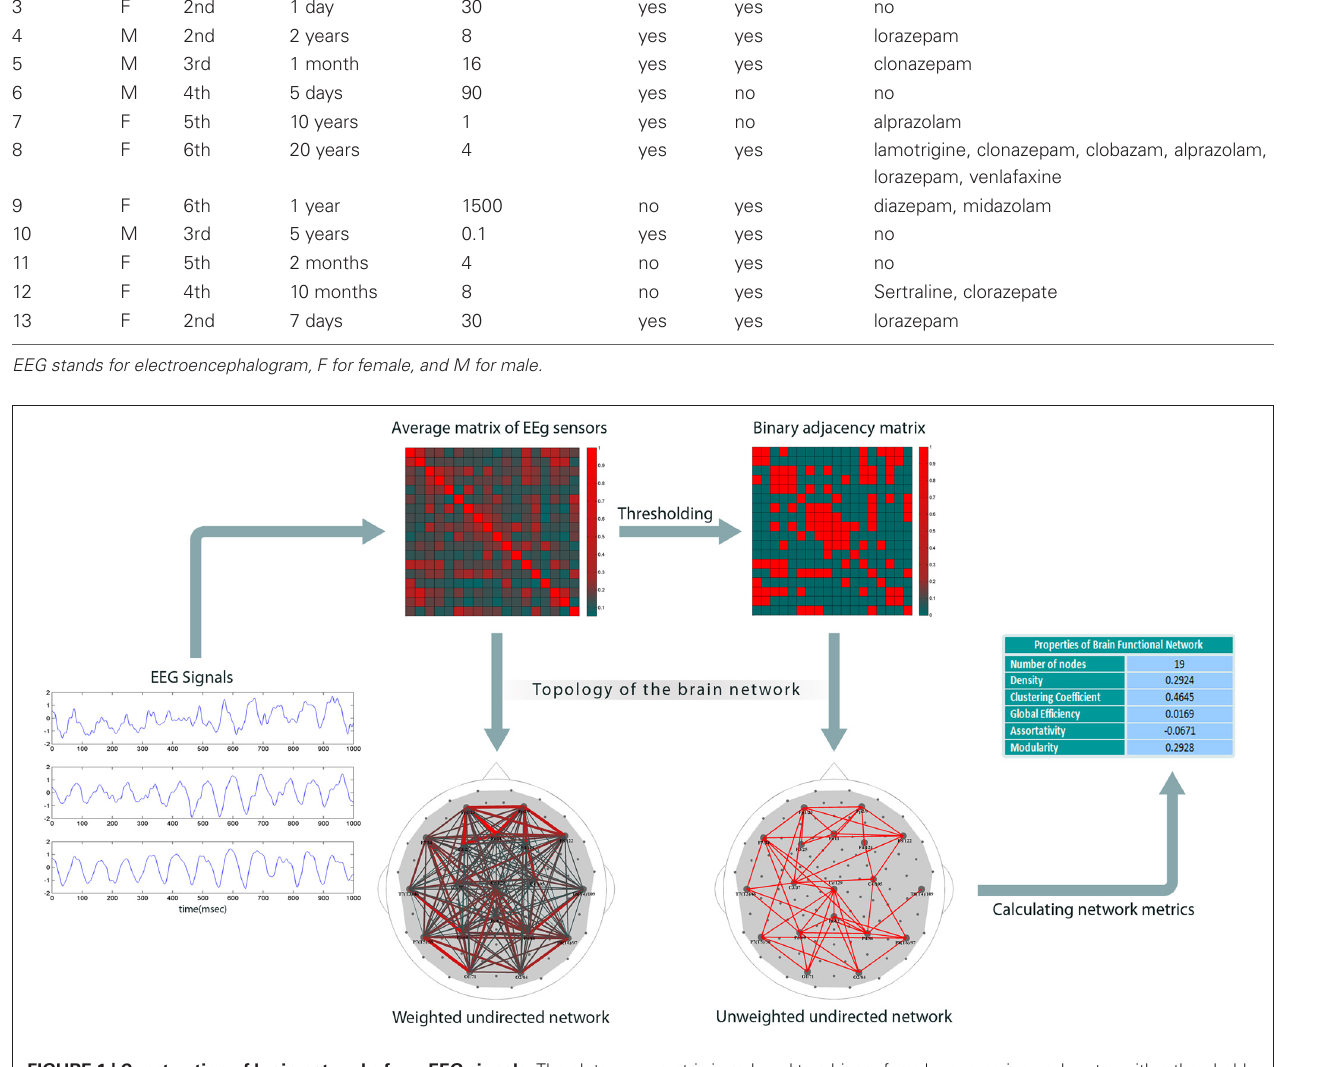
matrix is reduced to a binary form by comparing each entry with a threshold (the threshold is set such that the network has a specific density); the links with correlation values less than the threshold are set to 0; others to 1. Finally, graph theoretical metrics are calculated for the binary